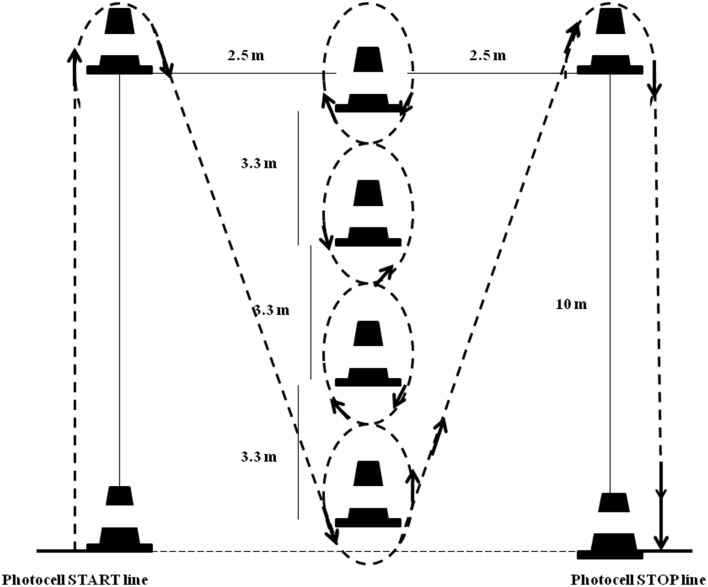
Schematic representations for Illinois Agility Test (IAT).